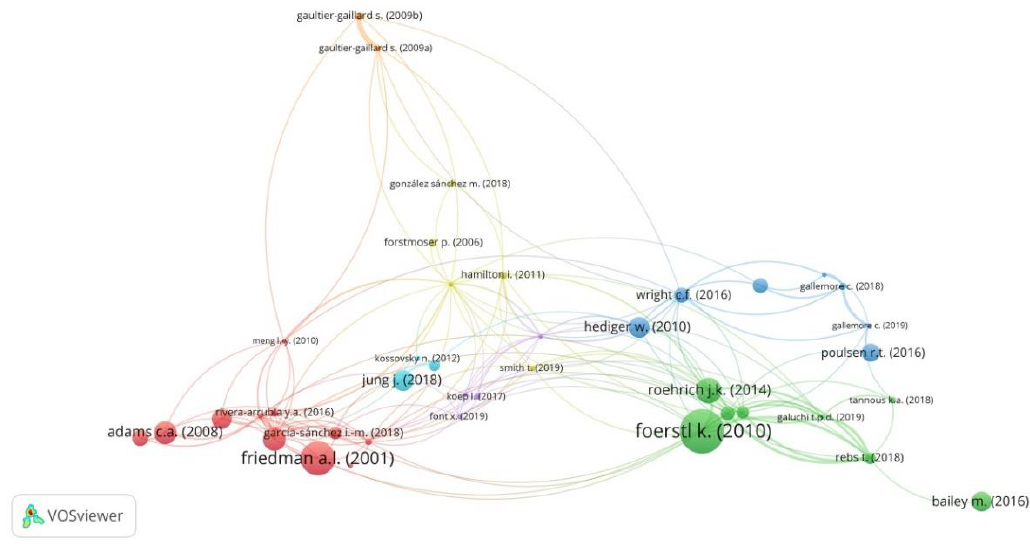
Figure 1. Document regarding keywords.